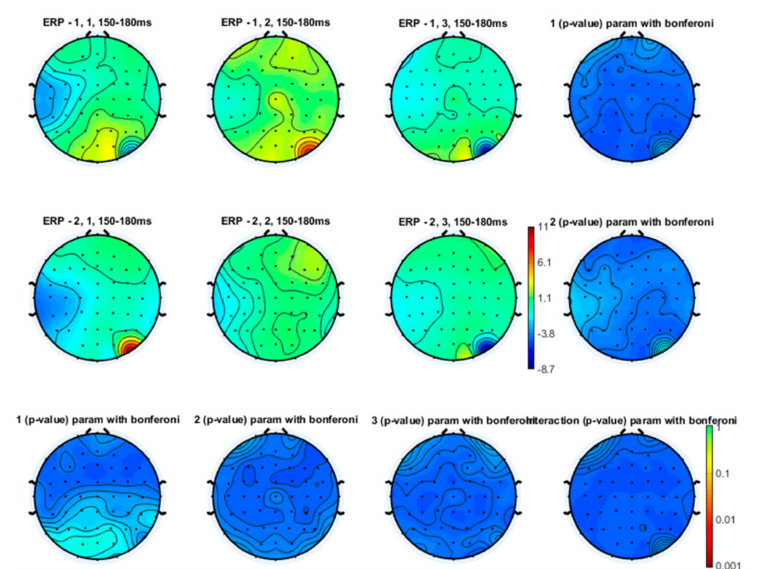
Figure 3. Topographical representation of the N1 wave on the right hand stimulation. The first line of topographical maps represents the N1 amplitude in the baseline condition, slow finger tapping (SFT) and fast finger tapping (FFT) in the control group. The second line of maps represents the N1 amplitude in the baseline condition, slow finger tapping (SFT) and fast finger tapping (FFT) in the patient group. The control group’s basal condition (1,1), slow finger tapping (1,2) and fast finger tapping (1,3); the fibromyalgia (FM) group’s basal condition (2,1), slow finger tapping (2,2) and fast finger tapping (2,3) (see also Figure 1). The results of the repeated measures analysis of variance (ANOVA) corrected with the Bonferroni test are reported.